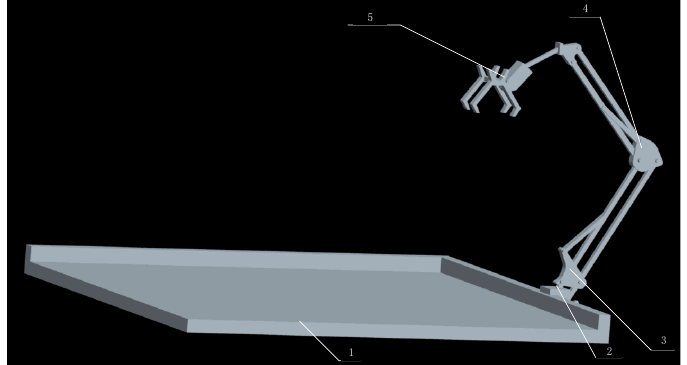
Figure 2. Image acquisition device. “1” is the standard measuring plate, “2” is the fixing clamp, “3” is the knob, “4” is the mechanical arm, and “5” is the end-effector.